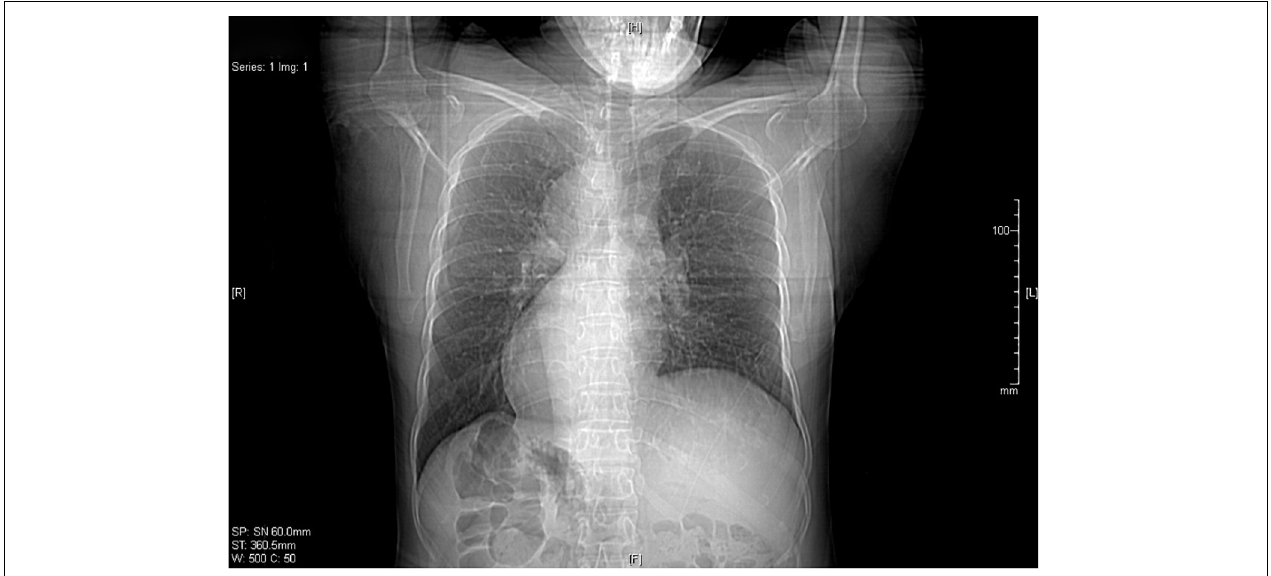
FIGURE 1 | Chest X-ray shows dextrocardia in this patient with situs inversus.